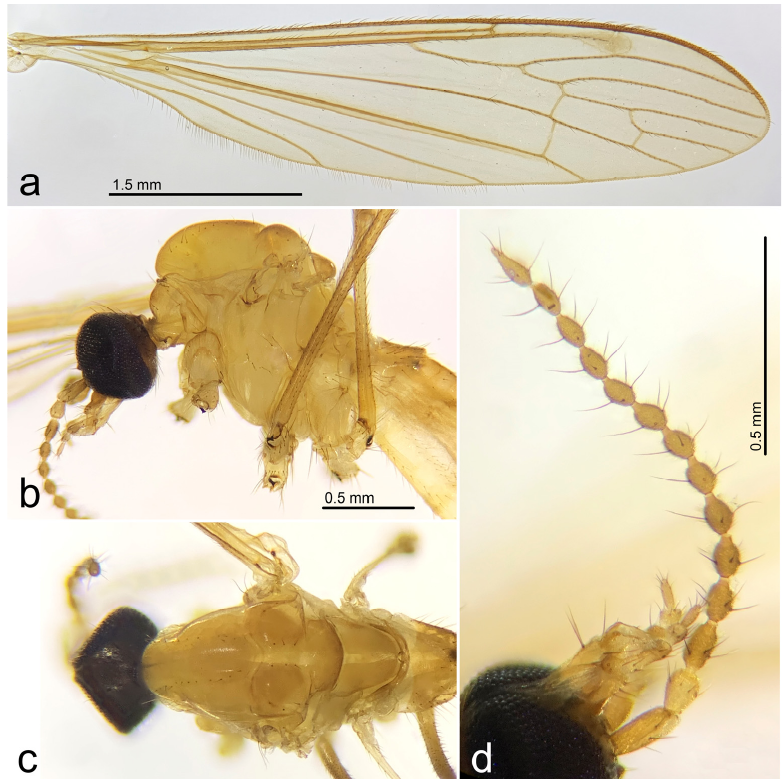
Figure 3. Atypophthalmus (Atypophthalmus) vanewrighti sp. nov., holotype male; ( a ) Right wing; ( b ) Head and thorax in lateral view; ( c ) idem in dorsal view; ( d ) Antenna.